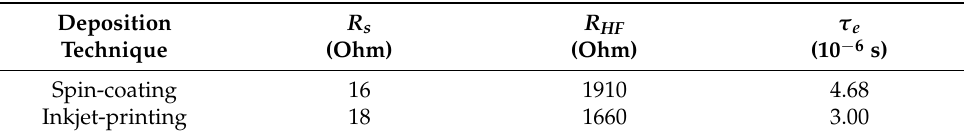
Figure 8. ( a ) Nyquist plots and ( b ) Bode phase diagrams for the solar cells fabricated by the different deposition techniques of the perovskite absorbent layer. Table 2. Parameters obtained from the EIS for solar cells fabricated by the different deposition techniques of the perovskite absorbent